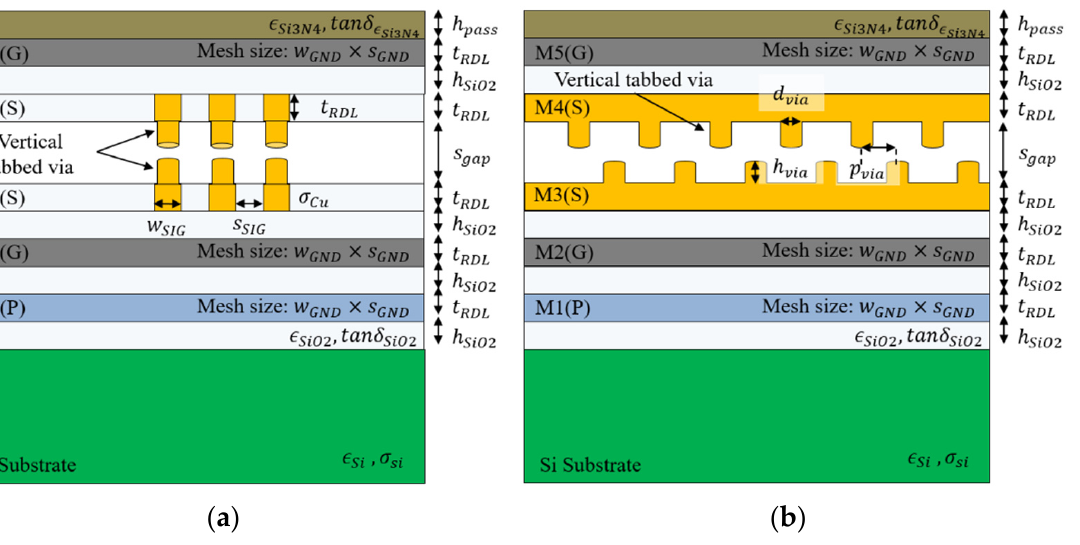
Figure 2. The proposed interposer channel structure: ( a ) front view and ( b ) side view. Second, the proposed channel structure has a vertical tabbed via. The vertical